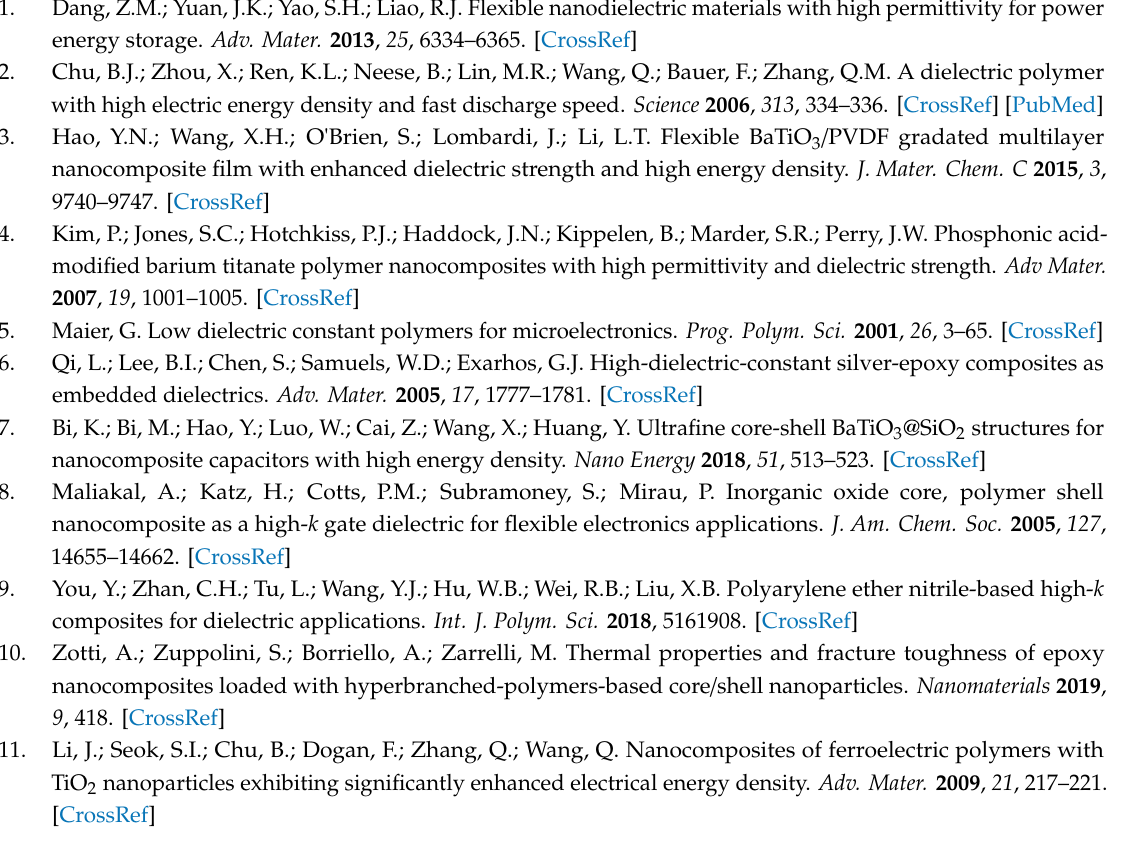
Figure S1: The DSC curves of PEN / PANI- f -BT nanocomposite films with di ff erent stretching ratios. Figure S2: The DSC curves of PEN / PANI- f -BT-b nanocomposite films with di ff erent stretching ratios. Figure S3: The electrical conductivity of PEN / PANI- f -BT